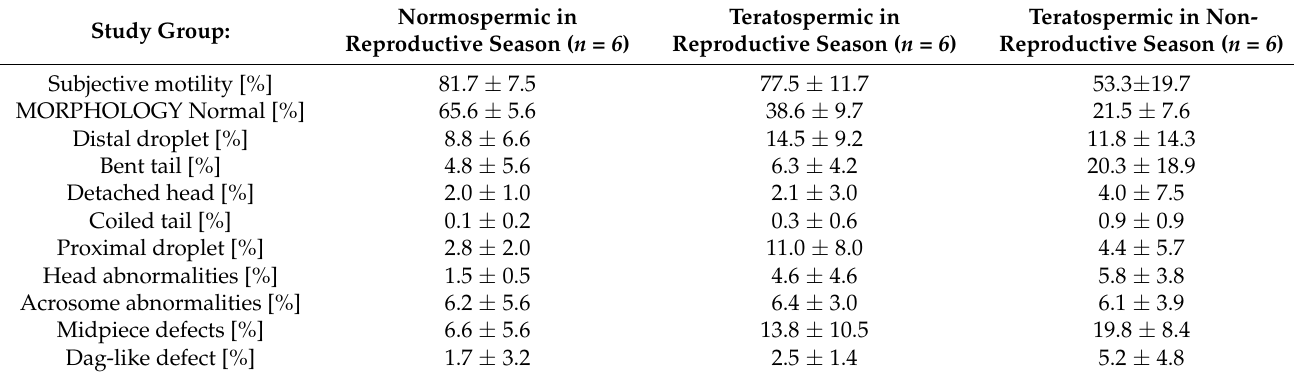
Table 3. Semen parameters of cats in Experiment II. Data presented as mean ±